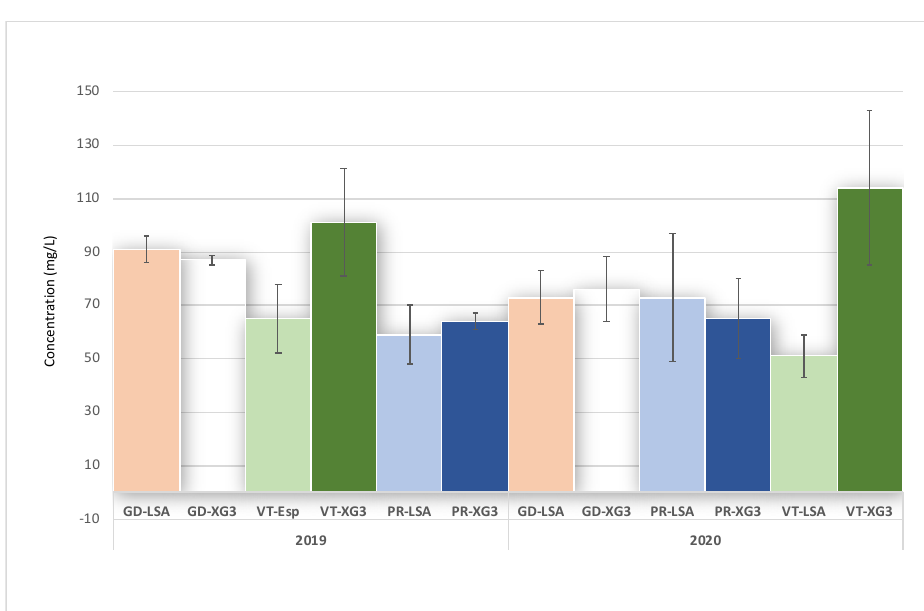
Figure 4. Total volatile concentration (mg/L) of Treixadura wines from Priorato de Razamonde (PR), O’Ventosela (VT) and Gandarela (GD) wineries obtained with different yeast in 2019 and 2020